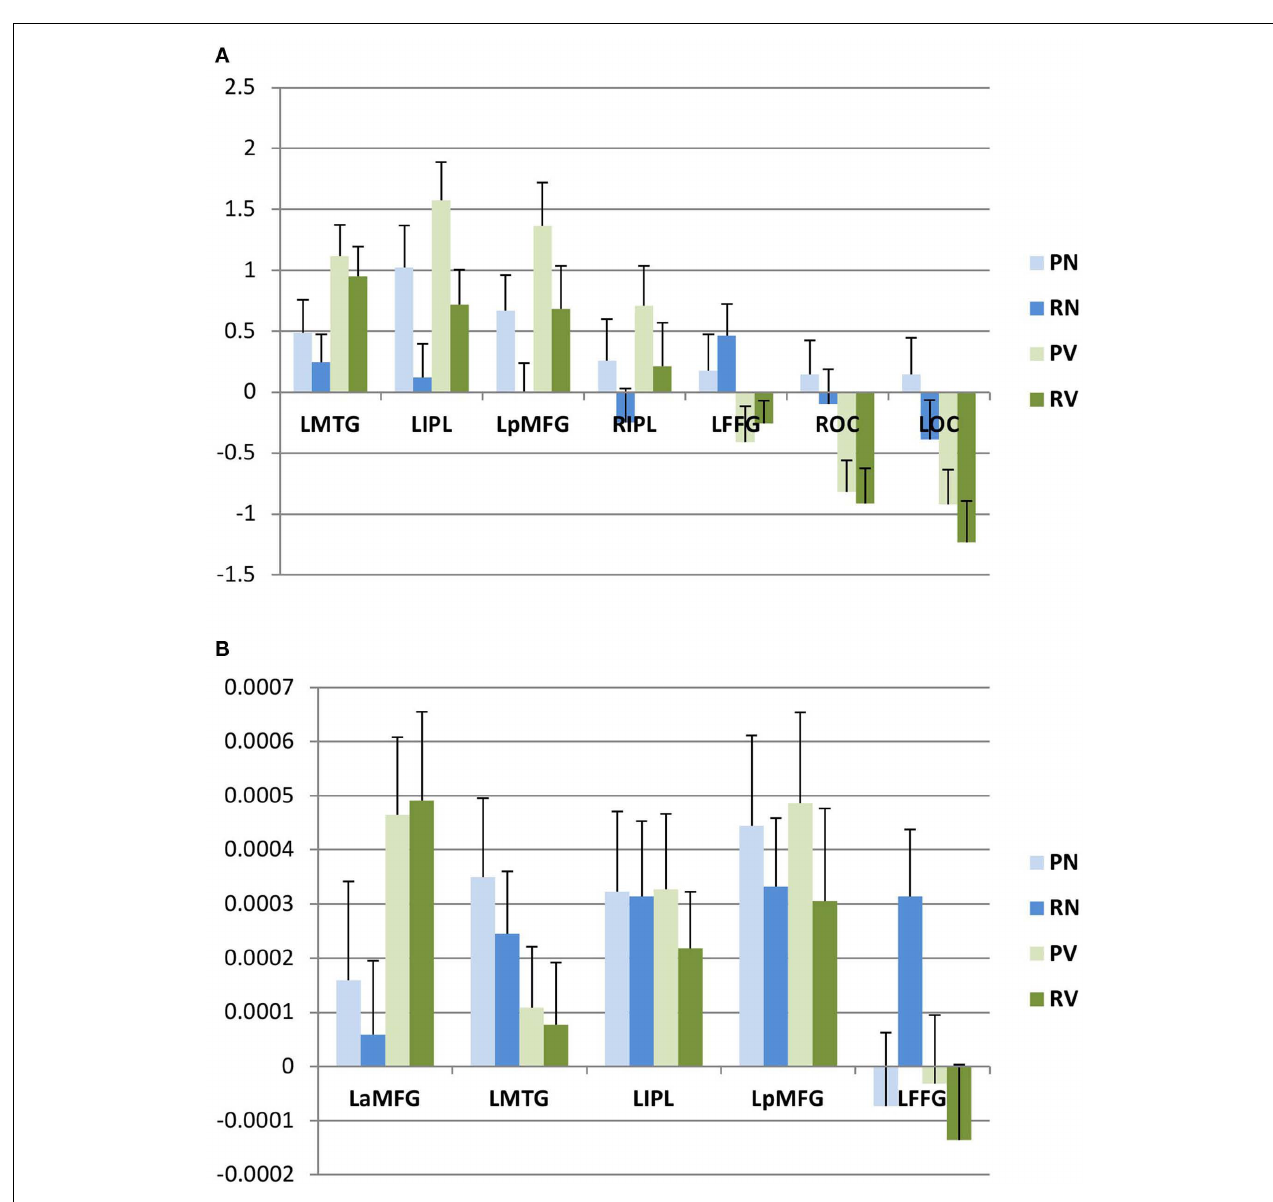
eigenvariates are plotted here. L, left; R, right; B, bilateral; a, anterior; p, posterior; MFG, middle frontal gyrus; IPL, inferior parietal lobule; MTG, middle temporal gyrus; FFG, fusiform gyrus; OC, occipital